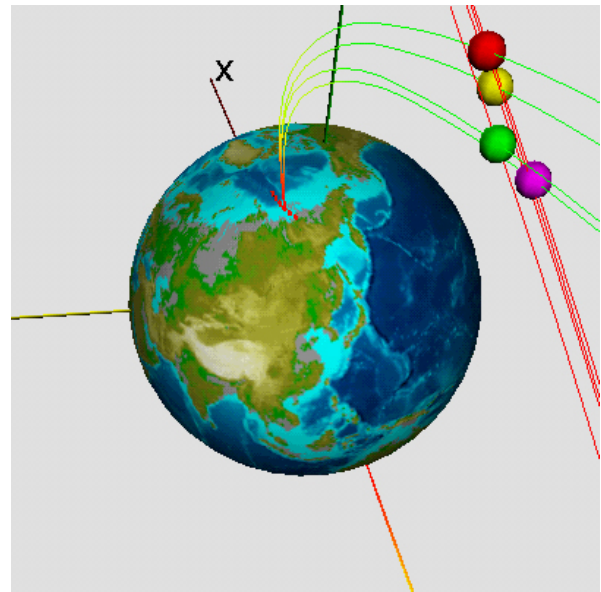
Fig. 39. Positions of the four Cluster spacecraft and geometry of the magnetic field lines deduced from OVT. The four spacecraft are going up; spacecraft 1 is red, spacecraft 2 is green, spacecraft 3 is yellow and spacecraft 4 is